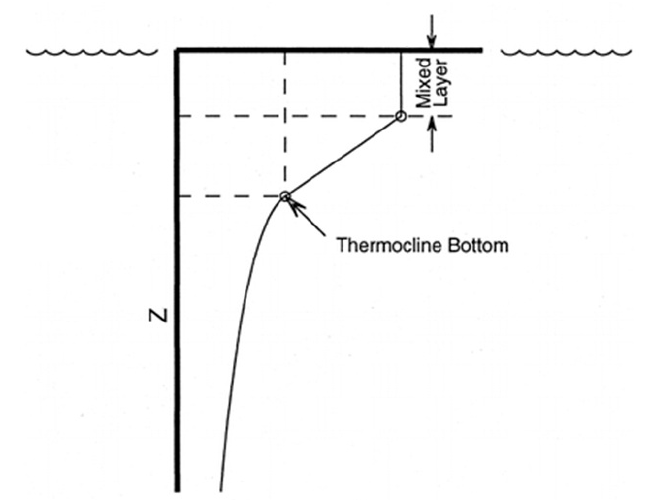
Figure 7. The mixed layer depth and thermocline bottom depth [53]. ©American Meteorological Society. Used with permission.